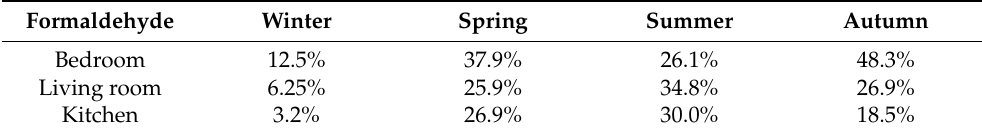
Figure 4. Distribution histogram of the infiltration rate.